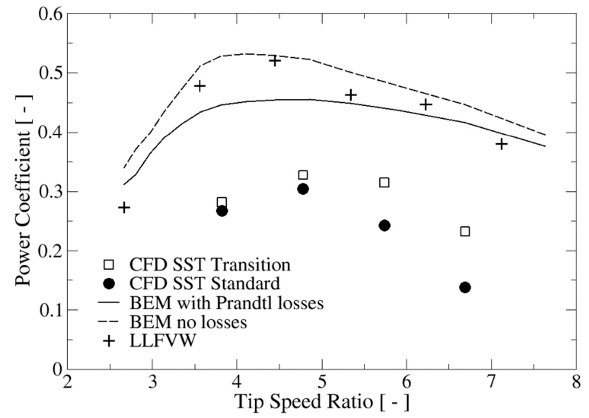
Figure 18. The comparison of the CFD results obtained in the present work versus those provided by BEM and LLFVM implemented in the Qblade software. The results computed by the SST Transition turbulence model are also included for